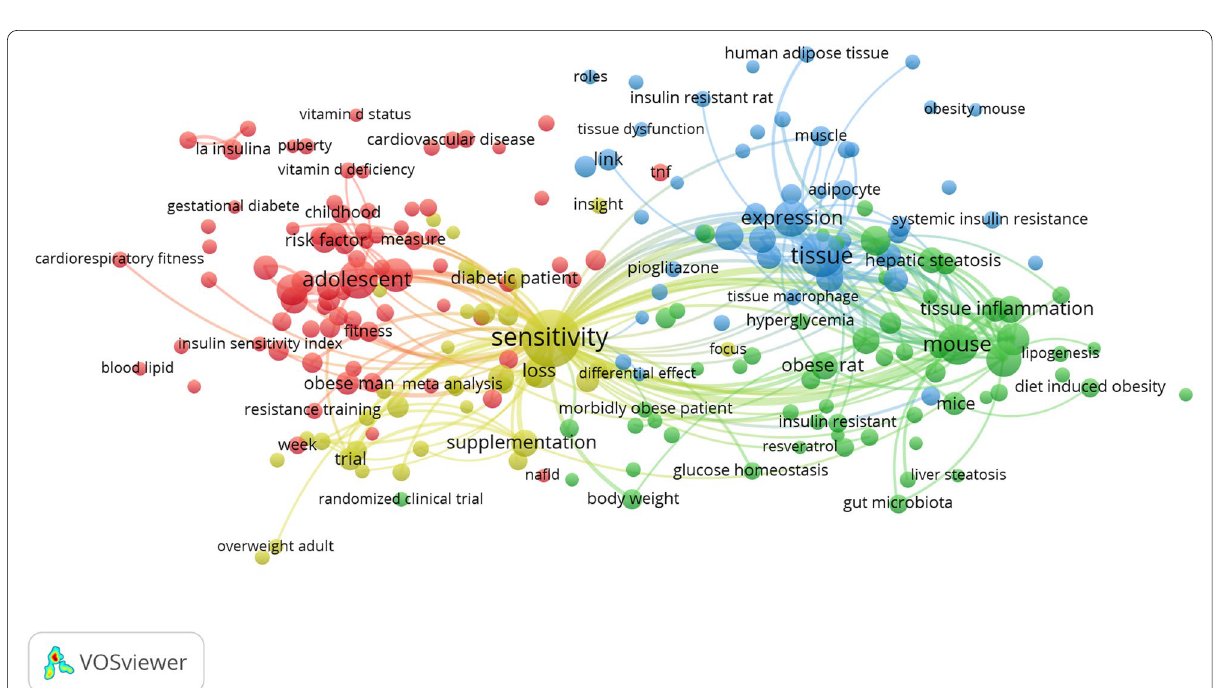
Fig. 5 Network visualization map of the analysis of terms in the titles with a minimum occurrence of ten or more ( n represent the main research topics encountered in the retrieved documents. The map was created using VOSviewer software version